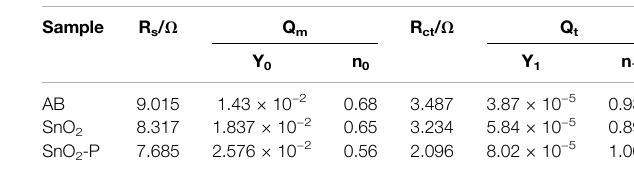
TABLE 1 | Fitting of electrochemical parameters for AB, SnO 2 , and SnO 2